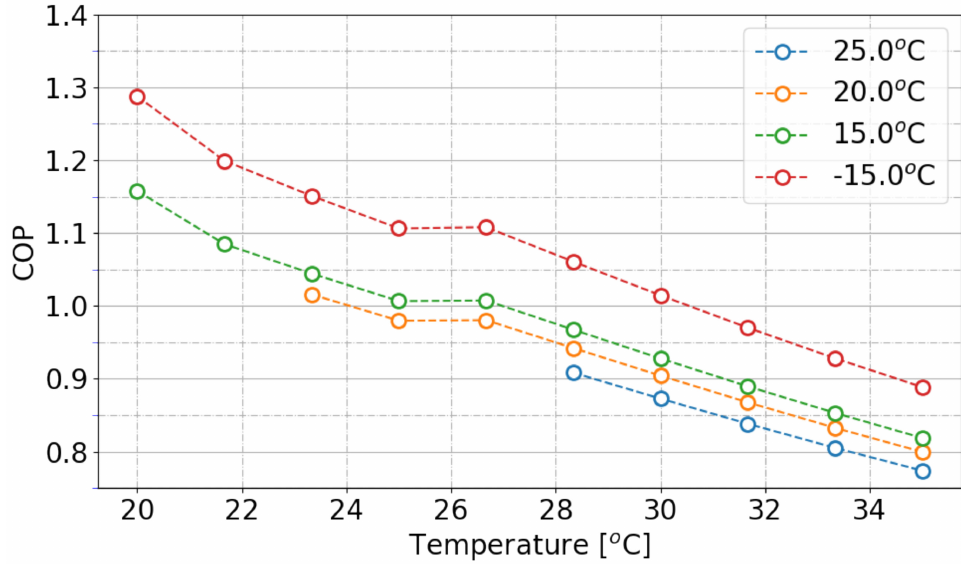
Figure 13. Investigation of COP of the proposed cycle for different cooled gas